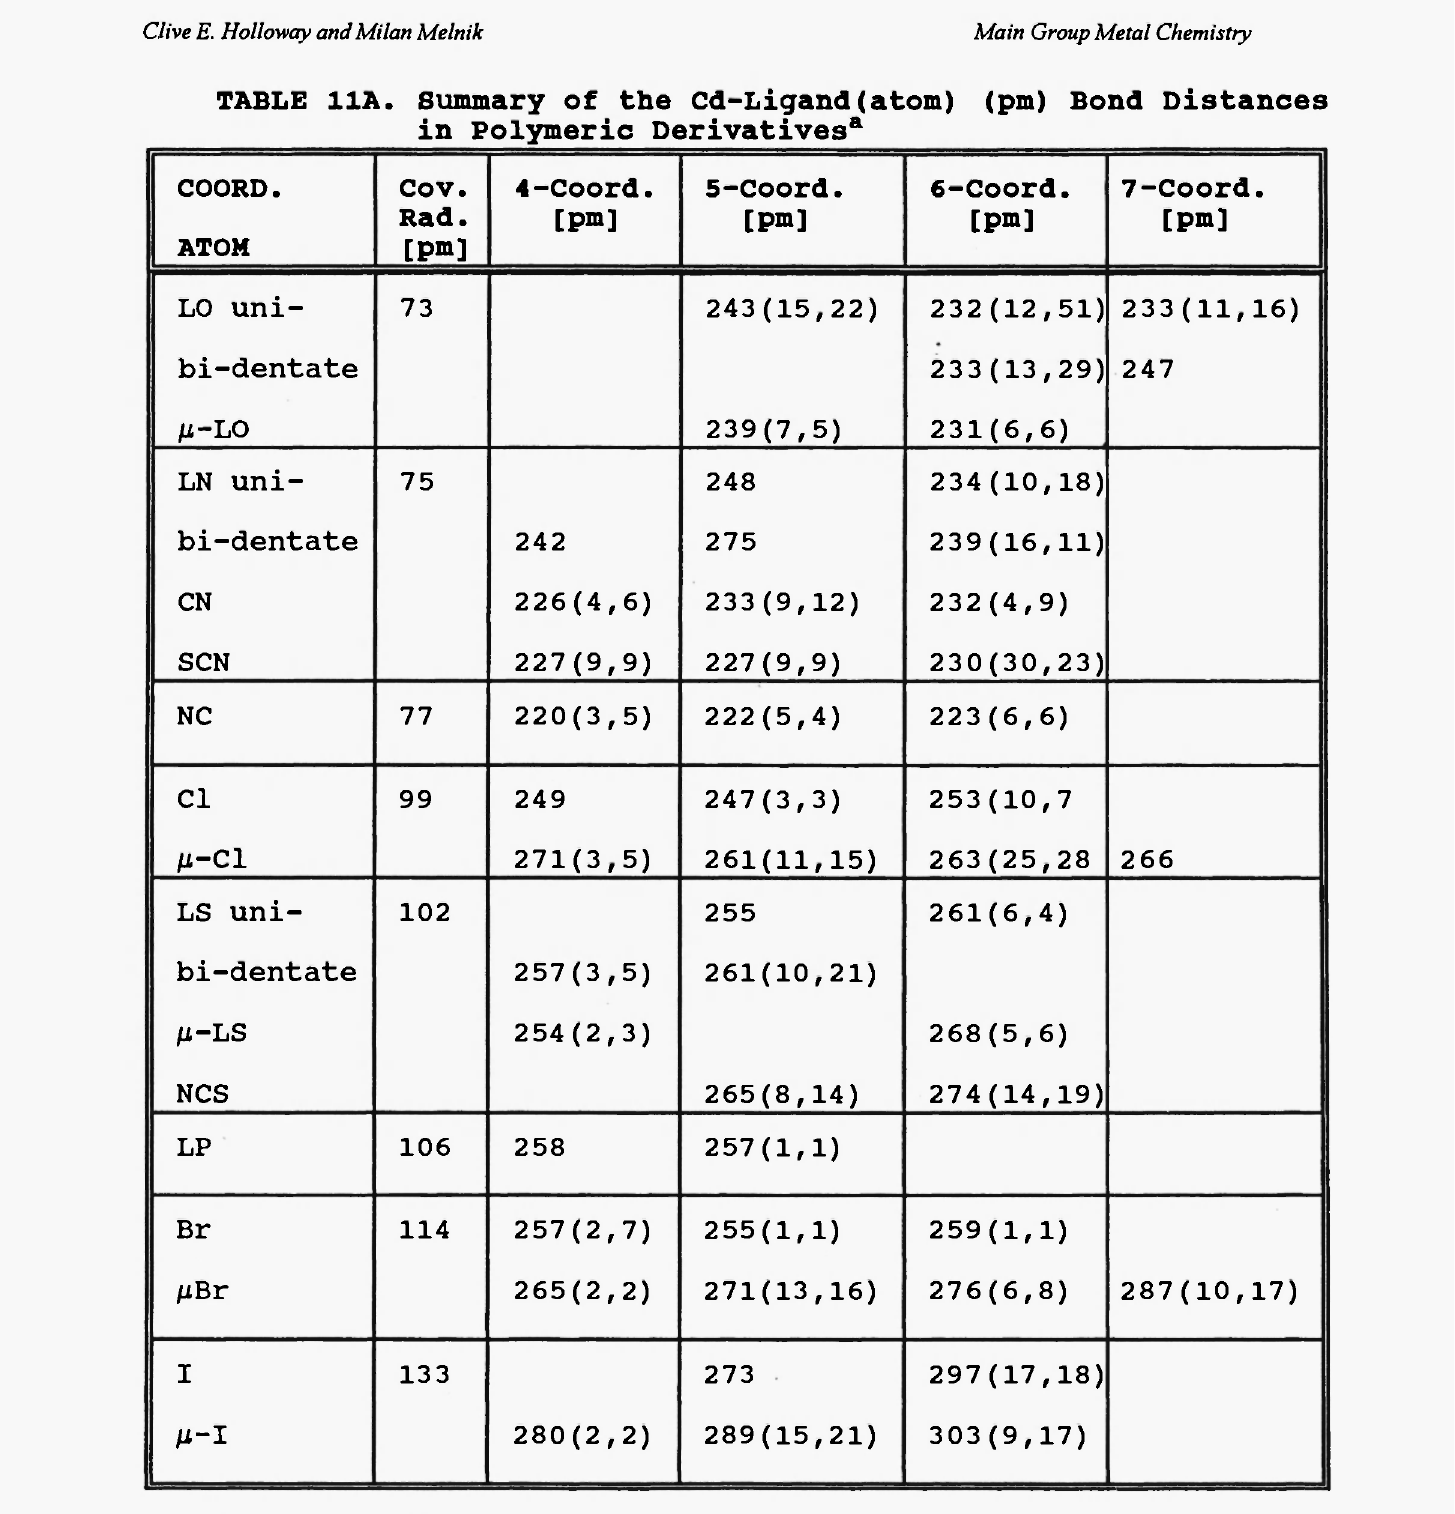
TABLE IIA. Summary of the Cd-Ligand(atom) (pm) Bond Distances in Polymeric Derivatives® COORD. Cov. 4-Coord, 5-Coord. 6-Coord. Rad. [pm] ATOM [pm]